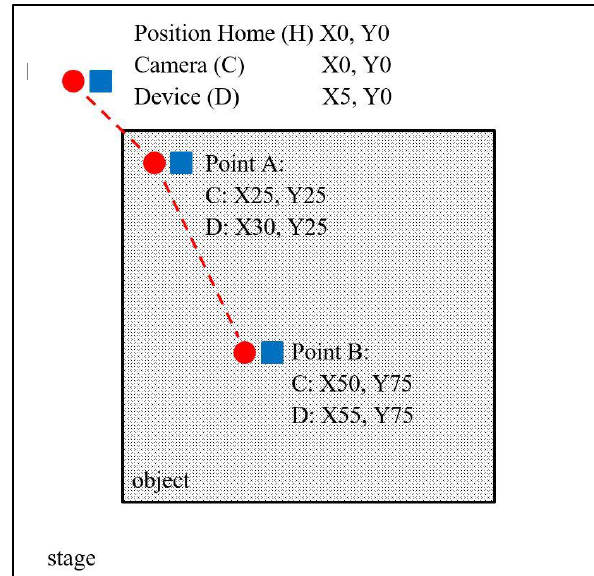
Figure 4 . Graphical example of G-code generated by XY axes movements, with example of the drift on the X axis that is generated by the distance between the center of the camera optic (red dot) and the center of the analytical device slit (blue